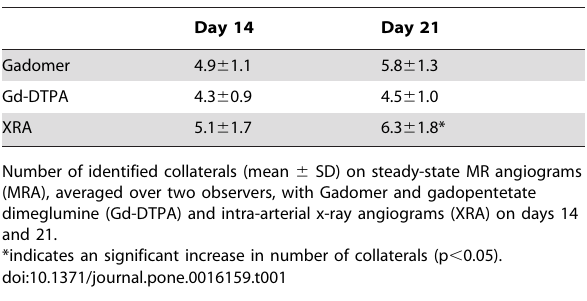
Figure S1 Signal enhancement time course. Signal enhancement time course for a range of contrast agent doses for Gadomer (panel a; range: 0.05–0.20 mmol/kg) and Gd-DTPA (panel b; range 0.10–0.50 mmol/kg). Grey shaded regions indicate the acquisition window for steady-state MRA in this study. (TIF)